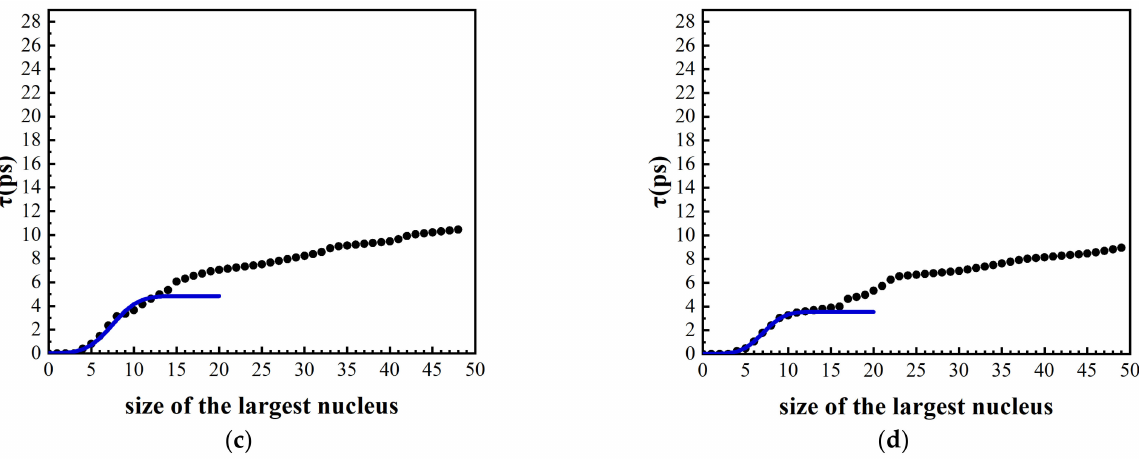
Figure 8. The mean first-passage time ( τ ) vs. the size of the largest nucleus ( n max ) during the isothermal-solidification process at ( a ) 0 MPa, ( b ) 100 MPa, ( c ) 200 MPa, and ( d ) 300 MPa,